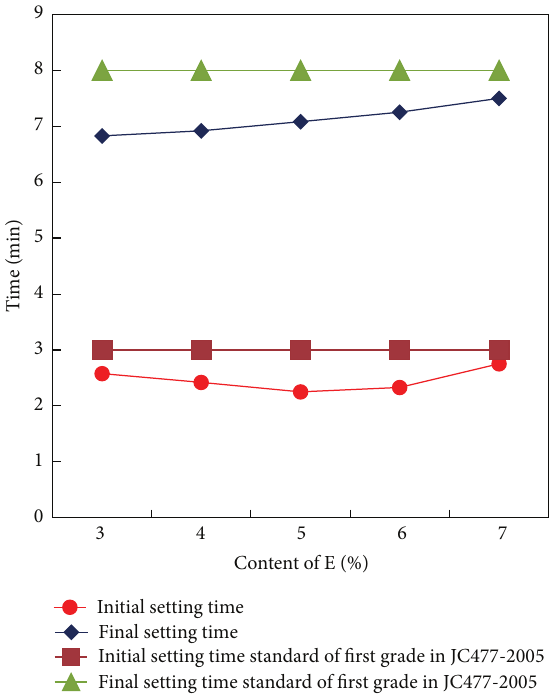
Table 11: Mass content of each component of WT-1 alkali-free liquid